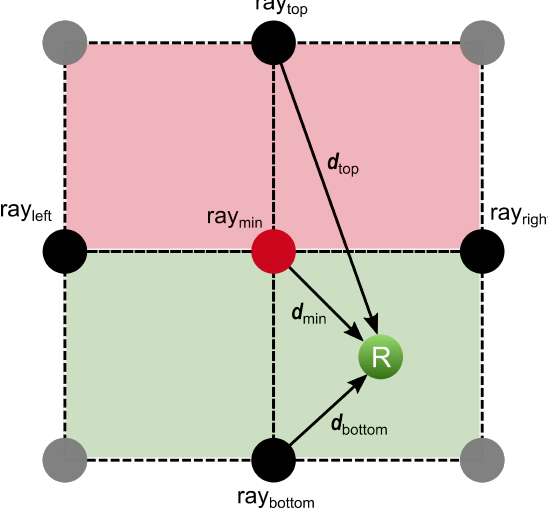
Figure 6. Vectors used to check whether receiver resides “ above ” or “ below ” the current ray of minimum distance. An analogous procedure can be done to check whether it is located “ left ” or “ right ”